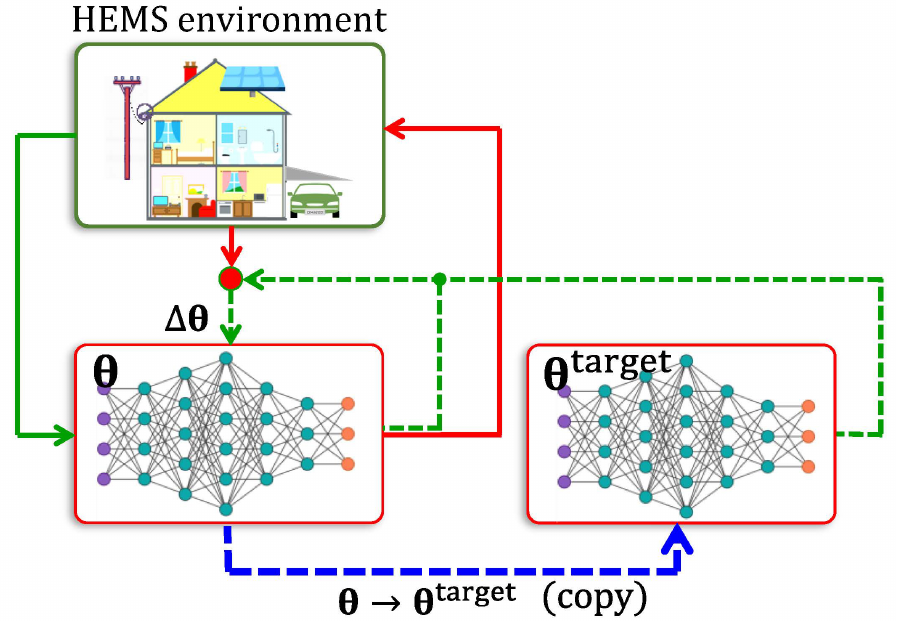
Figure 5. Use of Target Network. The scheme used to correct temporal correlatedness is shown. Pathways for control (solid red), learning (dashed green), and intermittent copying (dashed, thick blue) are shown. The replay buffer has been omitted for